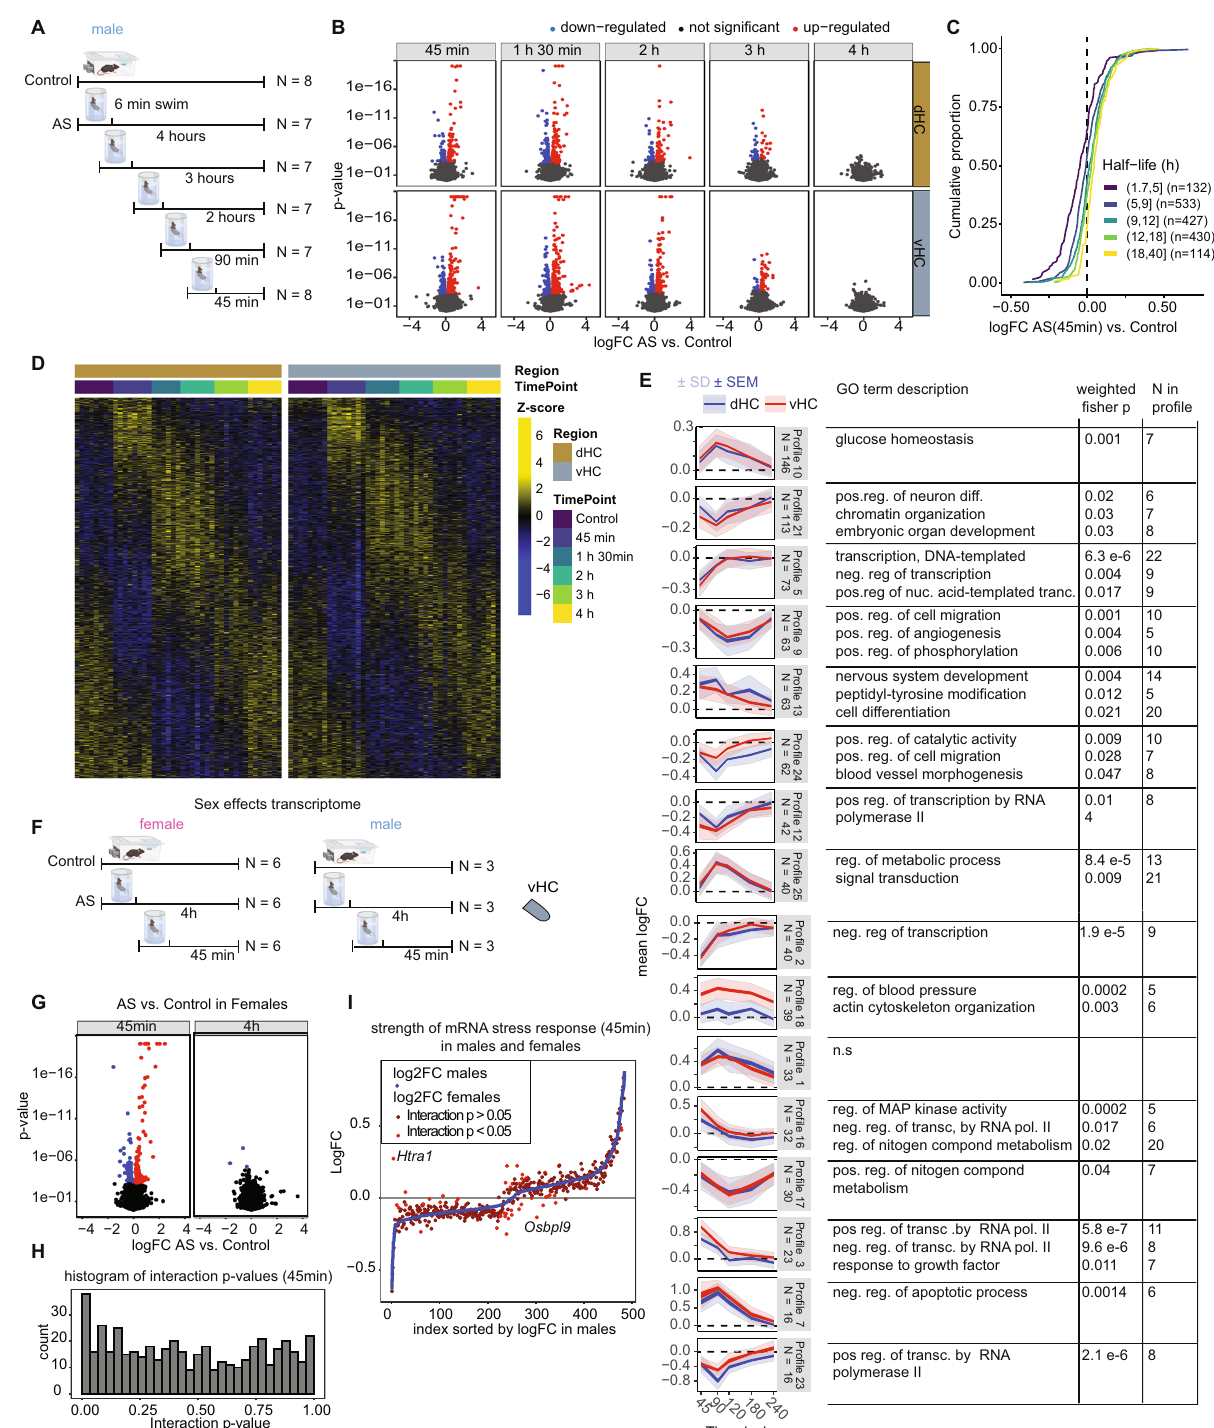
Sex effects transcriptome